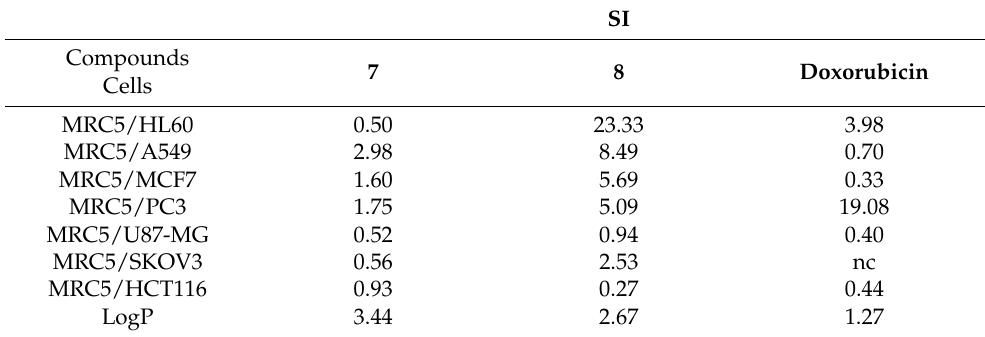
Table 3. Selectivity index (SI) of compounds 7 , 8, and doxorubicin .